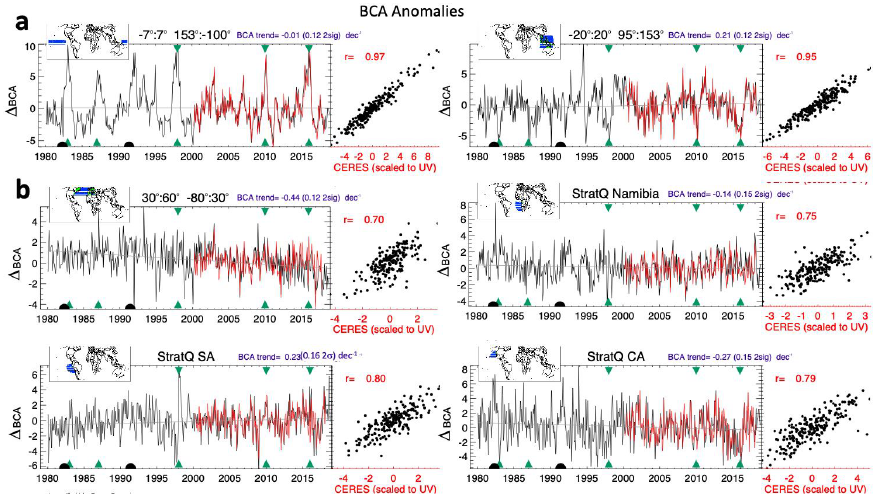
Figure 9. Monthly anomalies of UV BCA % (black trace) and shortwave cloud albedo from CERES (red trace) for selected geographic areas. ( a ) Regions with cloud response from ENSO; ( b ) the North Atlantic, and the three important stratocumulus decks off the coasts of Namibia, South America, and California.